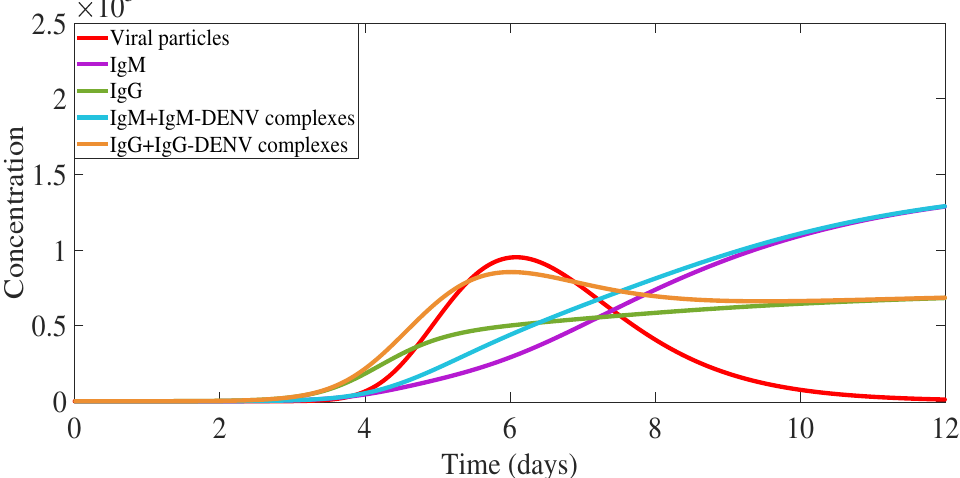
Figure 7. Model simulation: secondary dengue infection with a homologous serotype. Overall viral particles measured with free virus and viral particles in complexes ( ( V + 4 · IgM-DENV + IgG- DENV)). Free IgM is shown in violet and free IgG in green. Antibodies-virus complexes IgM-DENV and IgG-DENV are shown in blue and orange, respectively. The initial value of IgG antibody is set, G ( t 0 ) =